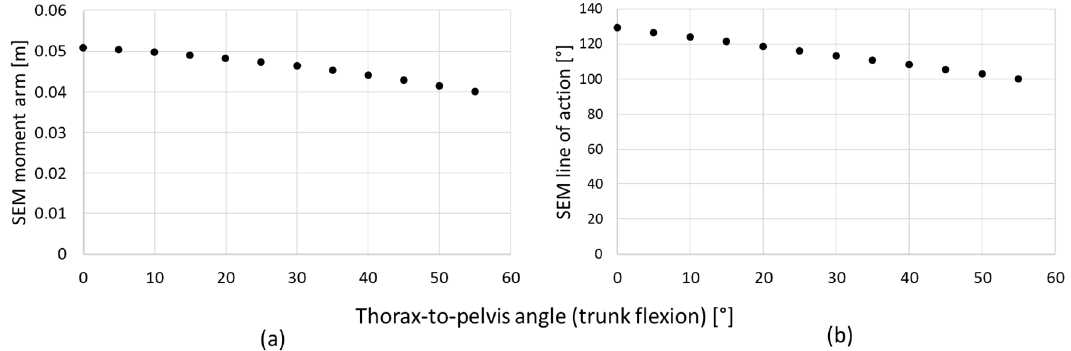
Figure 1. Variation of the back extensor muscle moment arm ( a ) and of the orientation of the line of action with respect to the plane of L5/S1 ( b ) from 0° to 55° of trunk flexion according to van Dieen’s single-equivalent muscle (SEM) model.